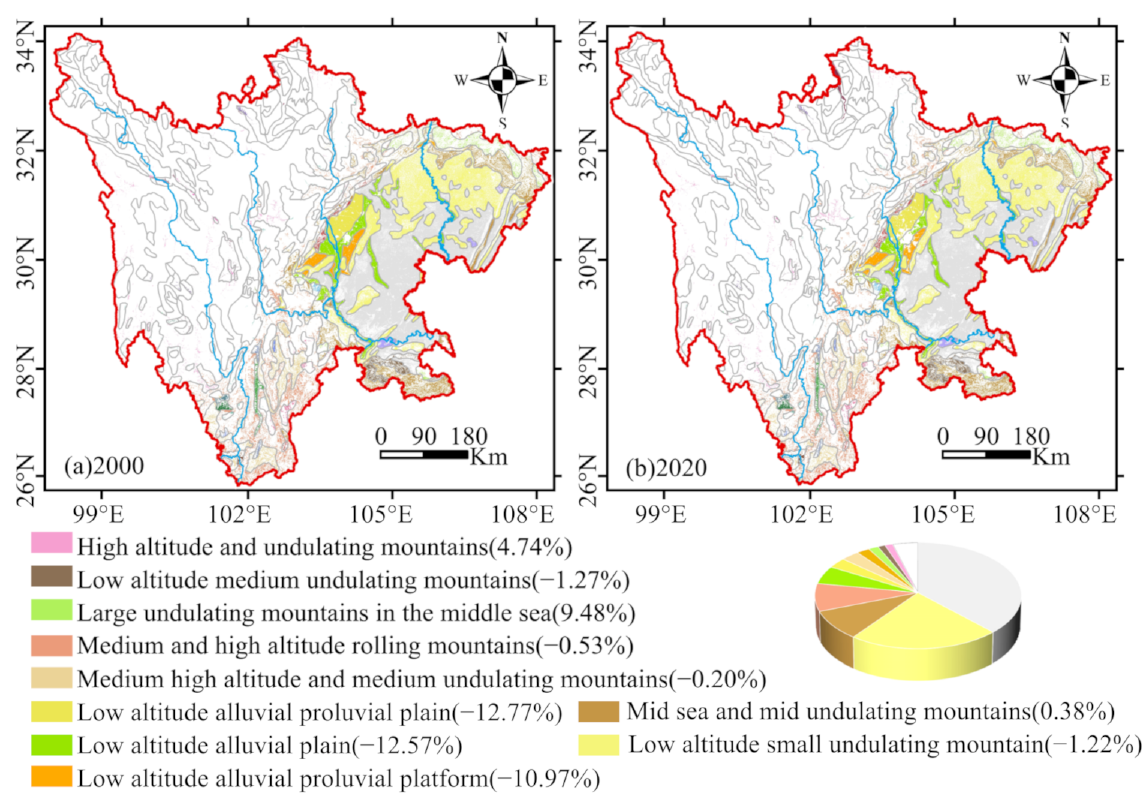
Figure 7. Cultivated land distribution changes in different geomorphic areas from 2000 to 2020.